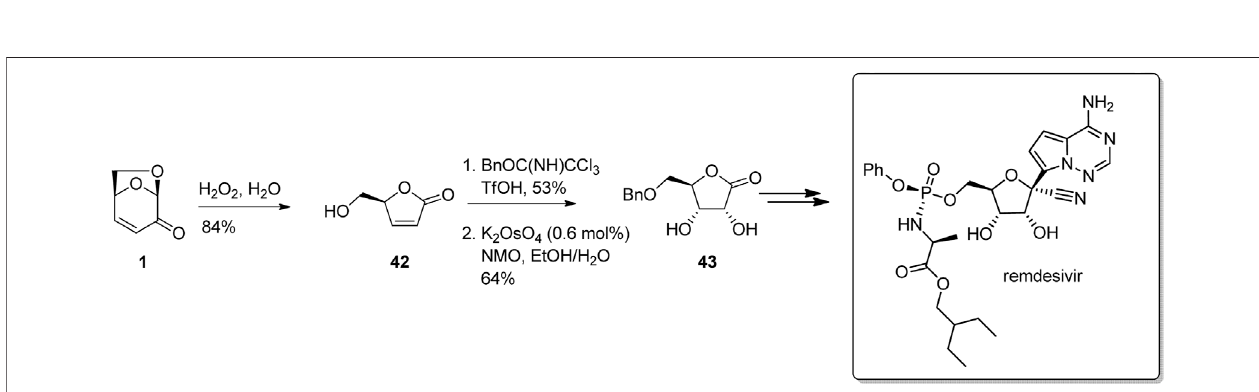
FIGURE 12 | Cycloaddition reactions of LGO for the preparation of carbonic anhydrase and RAS activation inhibitors.